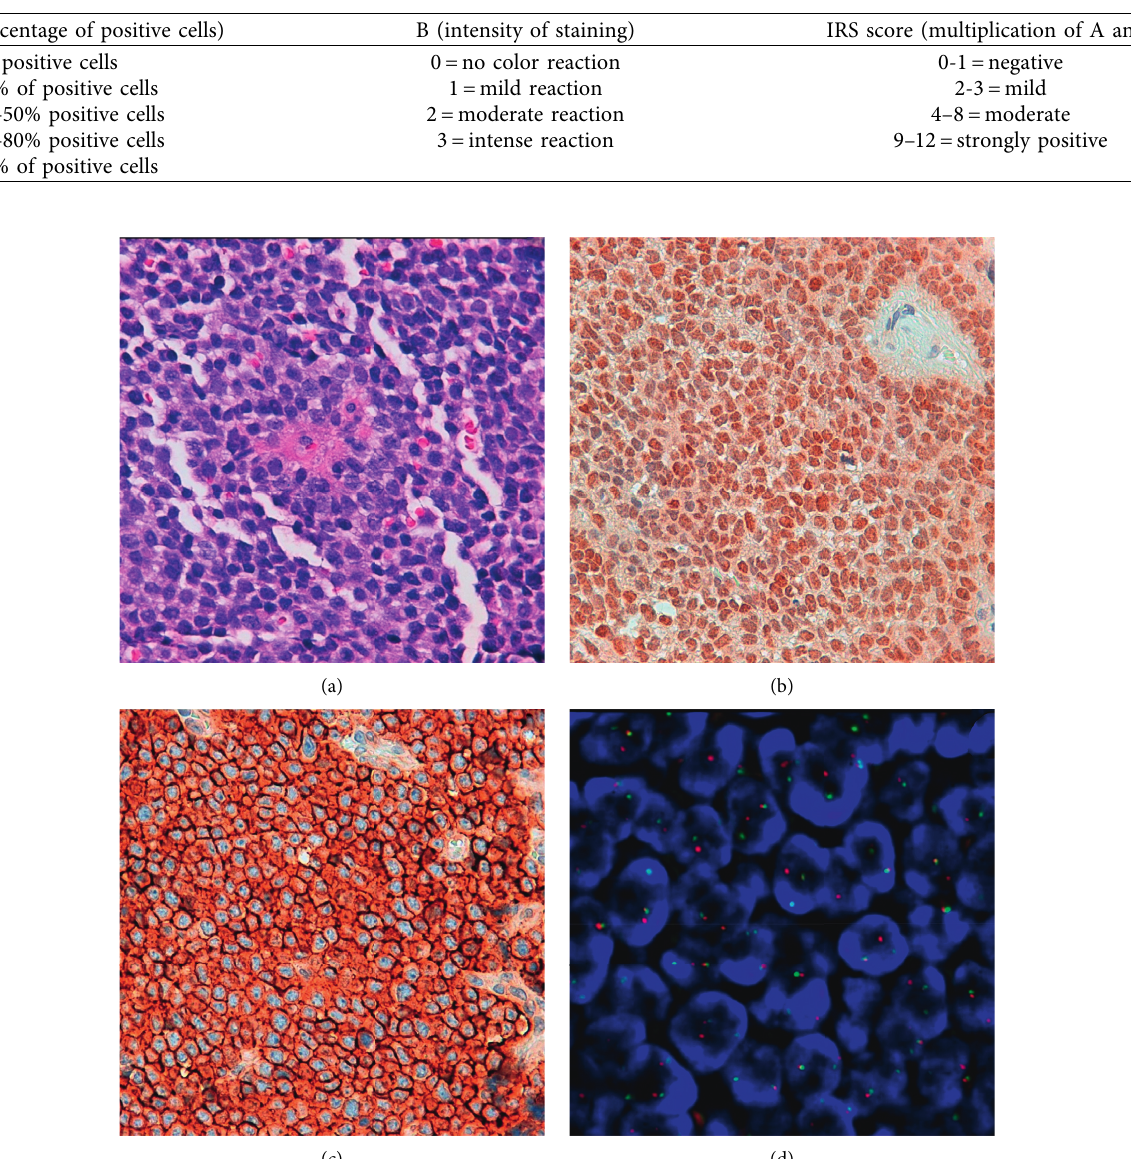
Table 3: The immunoreactive score (IRS).